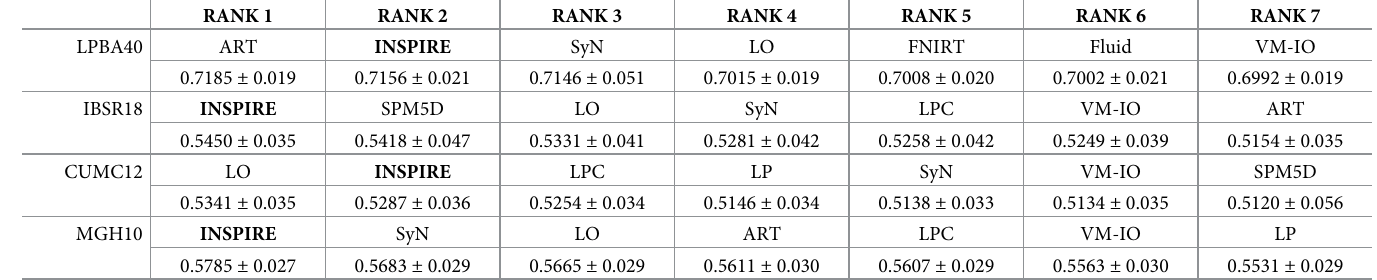
Table 4. Top 7 rankings of the compared methods (see [14]) w.r.t. the empirical mean of target overlap for the four datasets of brain volumes. Shown are empirical mean and std-dev of the target overlap. Lower rank is better and higher overlap value is better.